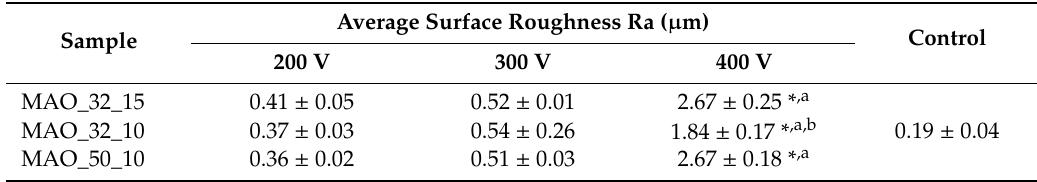
Table 3. Average surface roughness Ra ( µ m) of the investigated control specimens and MAO coatings with various MAO process parameters measured by laser